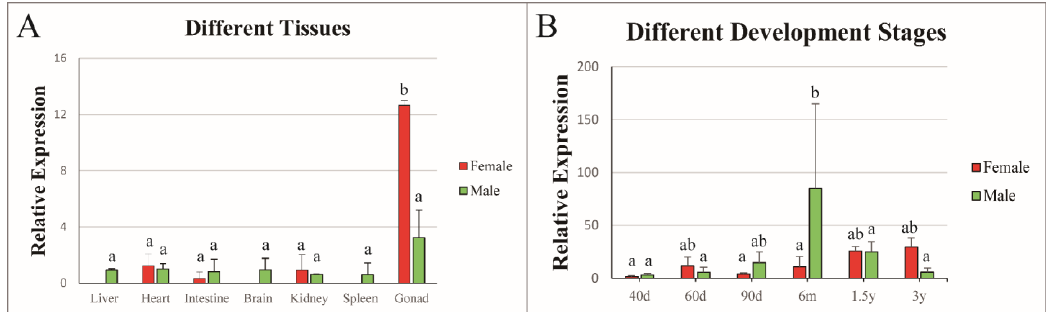
Figure 3. Relative expression of Cs-rchy1 in different tissues ( A ) and different developmental stages ( B ). Values are indicated as means ± S.D (N = 3). The expression levels with the same letter are not significantly different ( p < 0.05).